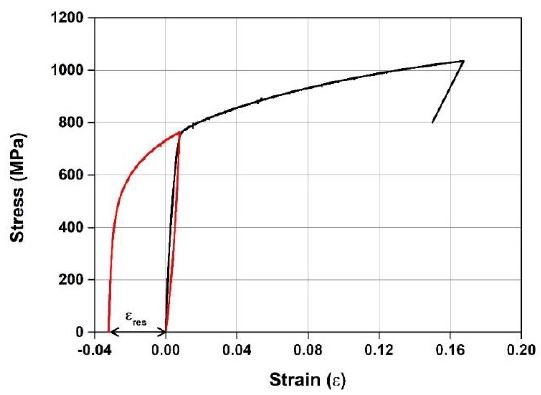
Figure 2. Stress – strain relationship of Fe-SMA rebar. Figure 2. Stress–strain relationship of Fe-SMA